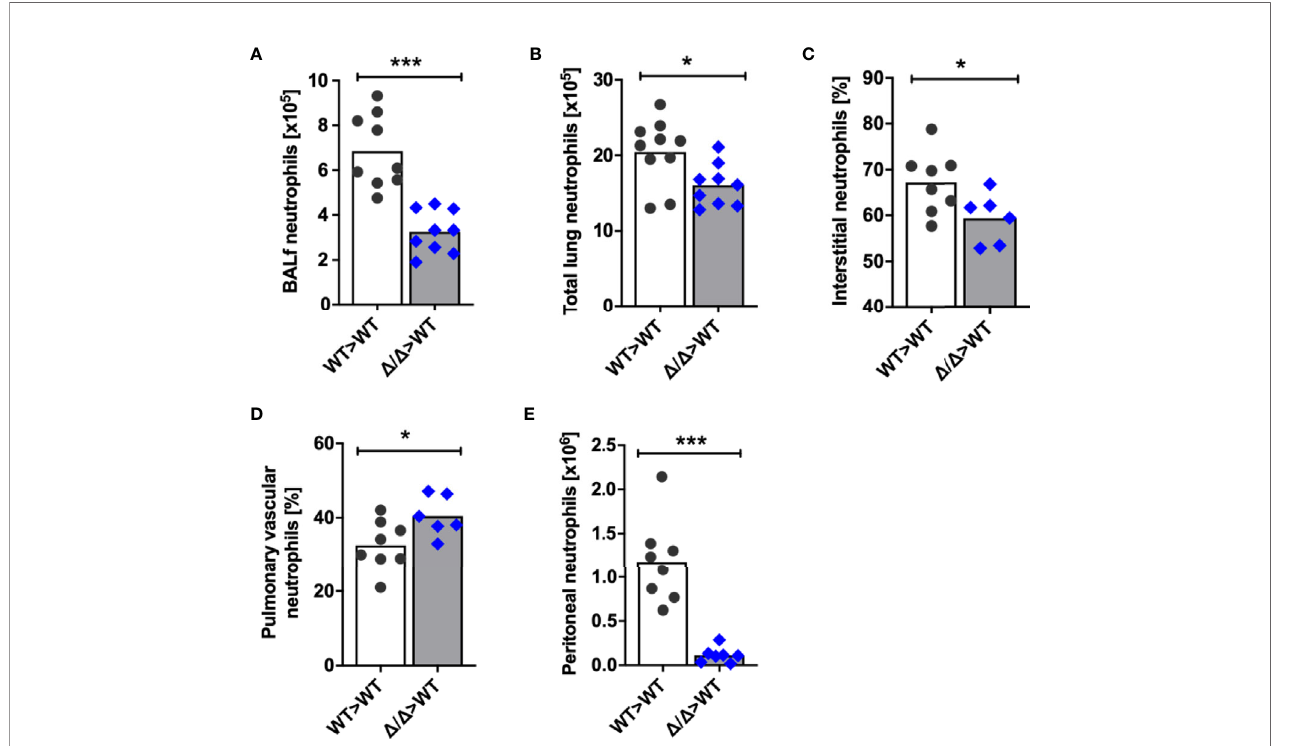
FIGURE 2 | SHIP2 activity is required for neutrophil recruitment to sites of sterile in fl ammation. (A – D) Neutrophil recruitment in acute lung injury (ALI). ALI was induced by administering 1 m g LPS in 50 m l sterile saline intratracheally into 9 wild-type (WT) and Ship2 D / D ( D / D ) bone marrow chimeras (generated with 4 bone marrow donors per genotype). Neutrophil numbers retrieved from (A) bronchoalveolar lavages and from (B) lung digests are plotted. (C, D) Chimeras were i.v. administered fl uorescently coupled anti-CD45 antibody prior to lavaging of saline-perfused lungs. Single-cell lung digests were then analyzed by fl ow cytometry. Percentages of (C) interstitial CD45 label-negative neutrophils and (D) pulmonary intravascular or partially transmigrated CD45 label-positive neutrophils are plotted. (E) Neutrophil recruitment in thioglycollate peritonitis. Peritonitis was induced by injecting 20ml/kg thioglycollate-containing broth into 8 wild-type and 7 Ship2 D / D bone marrow chimeras; the peritonea were fl ushed 2.5 hours later. Peritoneal neutrophil numbers are plotted. Experiments were performed on two separate days and results pooled in the graphs shown. Every symbol represents result obtained from one mouse, with means obtained indicated by bars; p values were determined by unpaired two-tailed t tests. * p < 0.05; *** p <